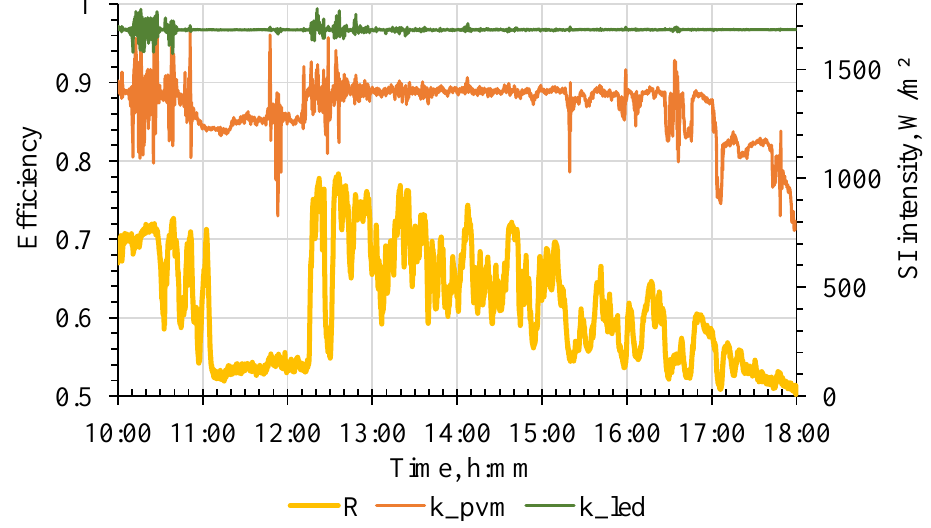
Figure 8. Efficiency of the converters: (R) SI intensity; (k PVM ) efficiency of the PVM step-up converter; (k LED ) efficiency of the current stabilizer of LED lamp.